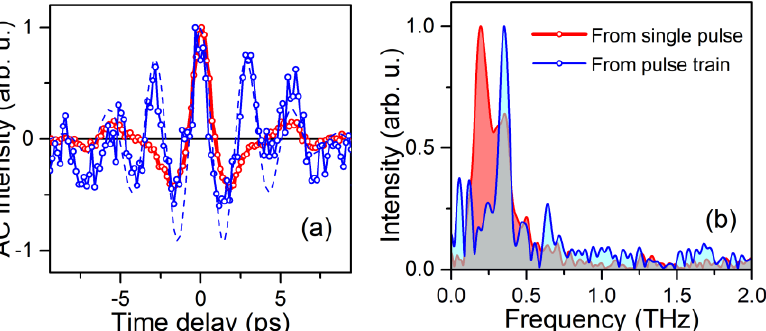
Fig. 3 . Autocorrelation traces (a) and Fourier-transform corresponding power spectra (b) for single- pulse and tunable pulse-train rectification in lithium niobate. Note that strong noise on the multicycle autocorrelation is due to absence of relative cavity length stabilization that is yet to be